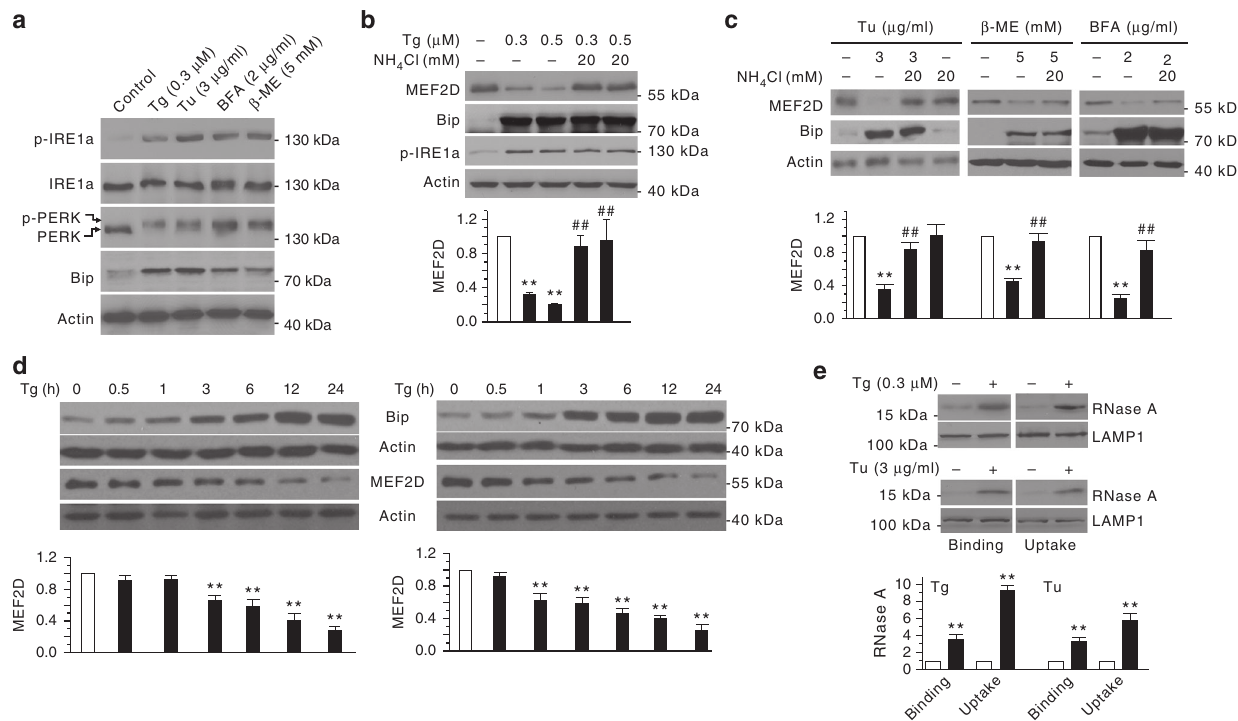
Fig. 1 ER stress activates CMA. a ER stressors induce UPR in SN4741 cells. SN4741 cells were treated for 5 h with Tg (Thapsigargin), Tu (Tunicamycin), β - mercaptoethanol ( β -ME), or brefeldin A (BFA). Various UPR markers were determined by immunoblotting (activated PERK has reduced mobility due to phosphorylation). b Inhibition of lysosomal activity attenuates Tg-induced MEF2D degradation. SN4741 cells were exposed to Tg with or without NH 4 Cl for 12 h. Protein levels of MEF2D, Bip, and phospho-inositol-requiring enzyme 1 (p-IRE1 α ) were determined. c Multiple ER stressors induce lysosomal dependent degradation of MEF2D. SN4741 cells were exposed to Tu, β -ME, BFA with or without NH 4 Cl for 12 h. d ER stress induces time-dependent degradation of MEF2D. Tg and Tu caused an increase of Bip level and a reduction of MEF2D level in SN4741 cells in a time-dependent manner. e ER stress enhances CMA activity in SN4741 cells. Lysosome binding (left panel) and uptake (right panel) of a commercially puri fi ed CMA substrate RNase A were determined after incubation with lysosomes isolated from SN4741 cells treated with or without Tg 0.3 μ M or Tu 3 µ g/ml for 12 h. LAMP1 was used as the lysosomal loading control. Bottom panels of b to e show the quanti fi cation of CMA substrate MEF2D or RNase A relative to untreated cells ( n = 3 of independent experiments). All values are mean ± s.d. (ANOVA with Turkey test for b , c and d , unpaired two-tailed t test for e ; ** p < 0.005 vs. control and ## p < 0.005 vs. Tg or Tu